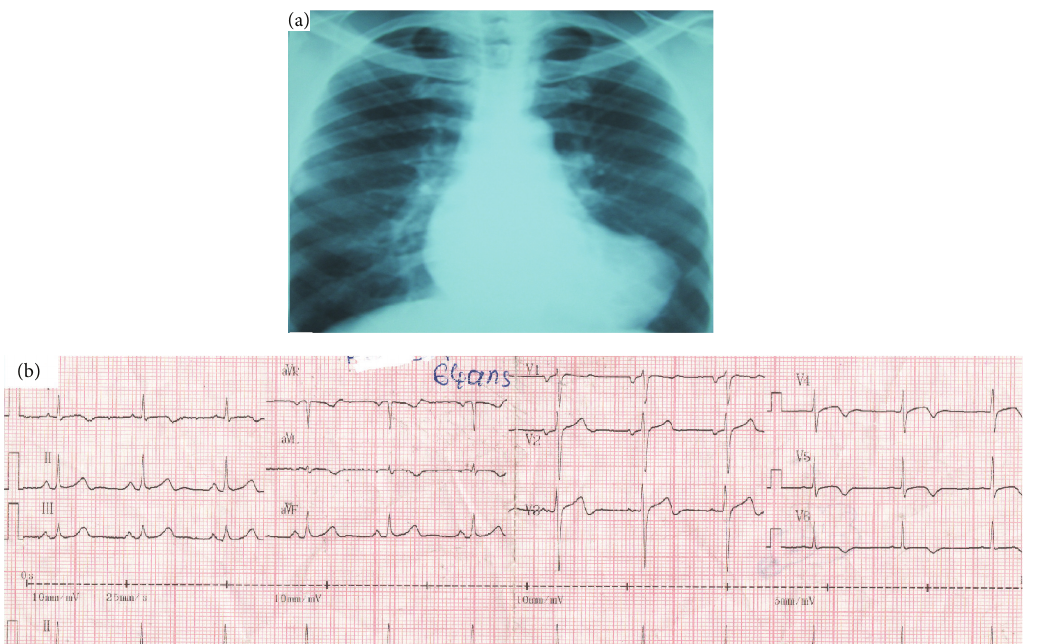
Figure 1: X-ray and electrocardiogram of this patient. (a) Front chest radiography, showing the deformation of the lower arc of left heart; (b) ECG was in sinus rhythm and objectified negative and symmetrical T waves in D1, aVL, V4, V5, and V6.